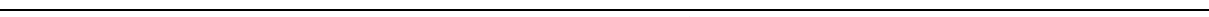
Fig. 5 Effect of nox2 mutation on Salmonella infection. a The survival of WT or nox2 − / − mice after oral infection with Salmonella (5 × 10 8 ) with or without GSK5182 treatment ( n = 10). According to log-rank, Mantel-Cox survival test, only WT mice showed overall survival gain with GSK5182 treatment upon Salmonella infection ( p < 0.002). b WT and nox2 − / − mice treated with PBS (FPN − ) or GSK5182 (FPN + ) were infected with Salmonella (5 × 10 8 CFU) orally. FPN and Salmonella in the spleen were examined by confocal microscopy 1.5 days p.i. using speci fi c antibodies. Nuclei were stained with DAPI (blue), and Salmonella (red) and FPN (green) with speci fi c antibodies. c Bacterial numbers (CFU/g) in the spleens of WT and nox2 − / − mice treated with GSK5182 were counted using the plating method. d Peritoneal macrophages were isolated from WT and nox2 − / − mice, treated with PBS, hepcidin (1 μ g/ml), FeSO 4 (0.1 mM), or DFO (100 μ M), and infected with Salmonella carrying episomal iroBp-gfpOVA or katGp-gfpOVA biosensors. The fraction of intra-macrophage Salmonella expressing gfpOVA was determined. e WT and nox2 − / − mice were infected orally with Salmonella carrying the episomal katGp-gfpOVA biosensor (5 × 10 8 ) and treated with PBS (FPN + ) or GSK51812 (FPN − ). Spleens were examined by confocal microscopy 1.5 days p.i. Salmonella are shown in red and katGp-gfpOVA expression is shown in green. f The fraction of Salmonella expressing katGp-gfpOVA in the experiment shown in e . Data are presented as means ± SEM. Signi fi cance is indicated as *** p < 0.001; **** p < 0.0001 by two-tailed Student ’ s t